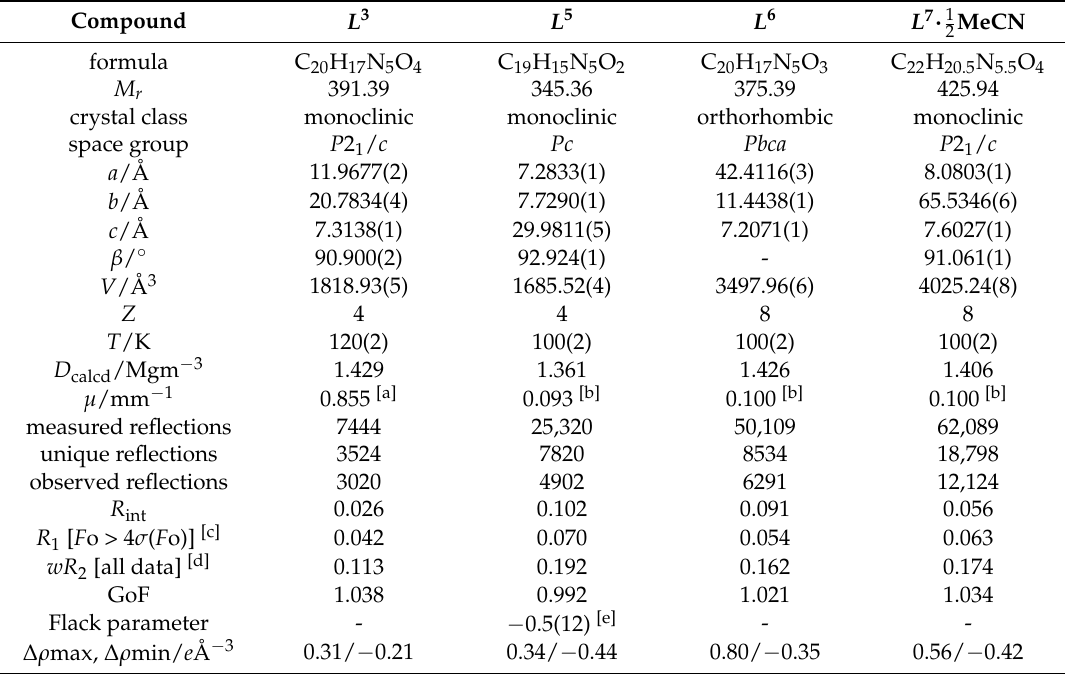
Table 3. Experimental details for the organic ligand crystal structures in this